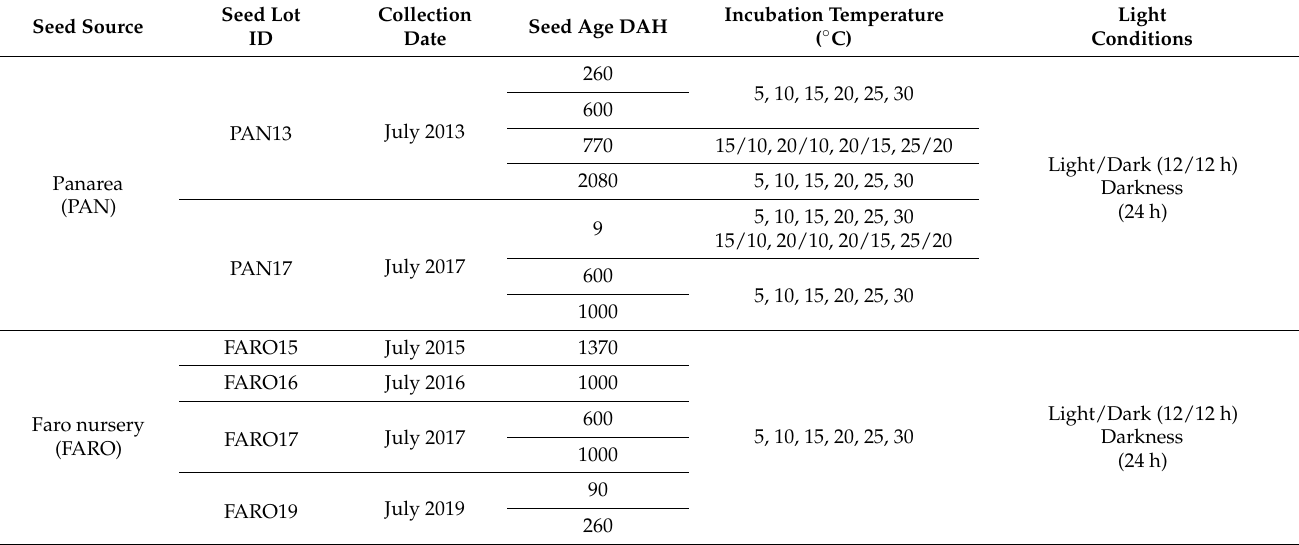
Table 2. Experimental design of the germination tests conducted in the laboratory: DAH = days after harvest. Seed Lot Seed Source